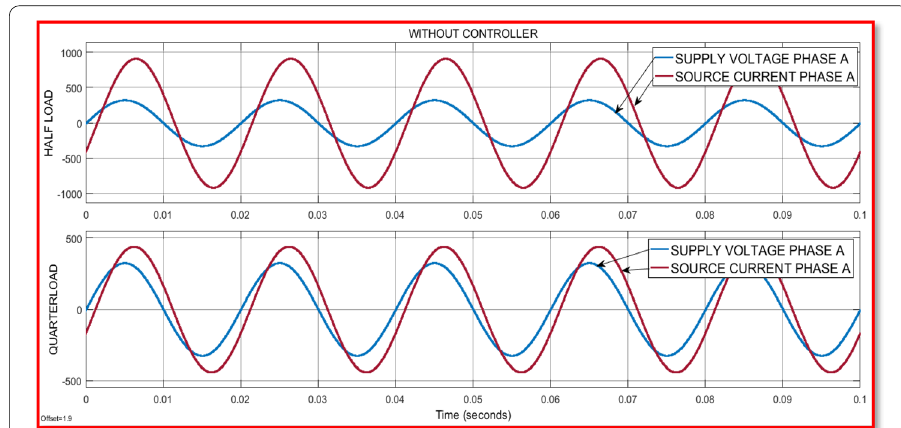
Fig. 18 Voltage and current wave forms of Phase A showing pf angle